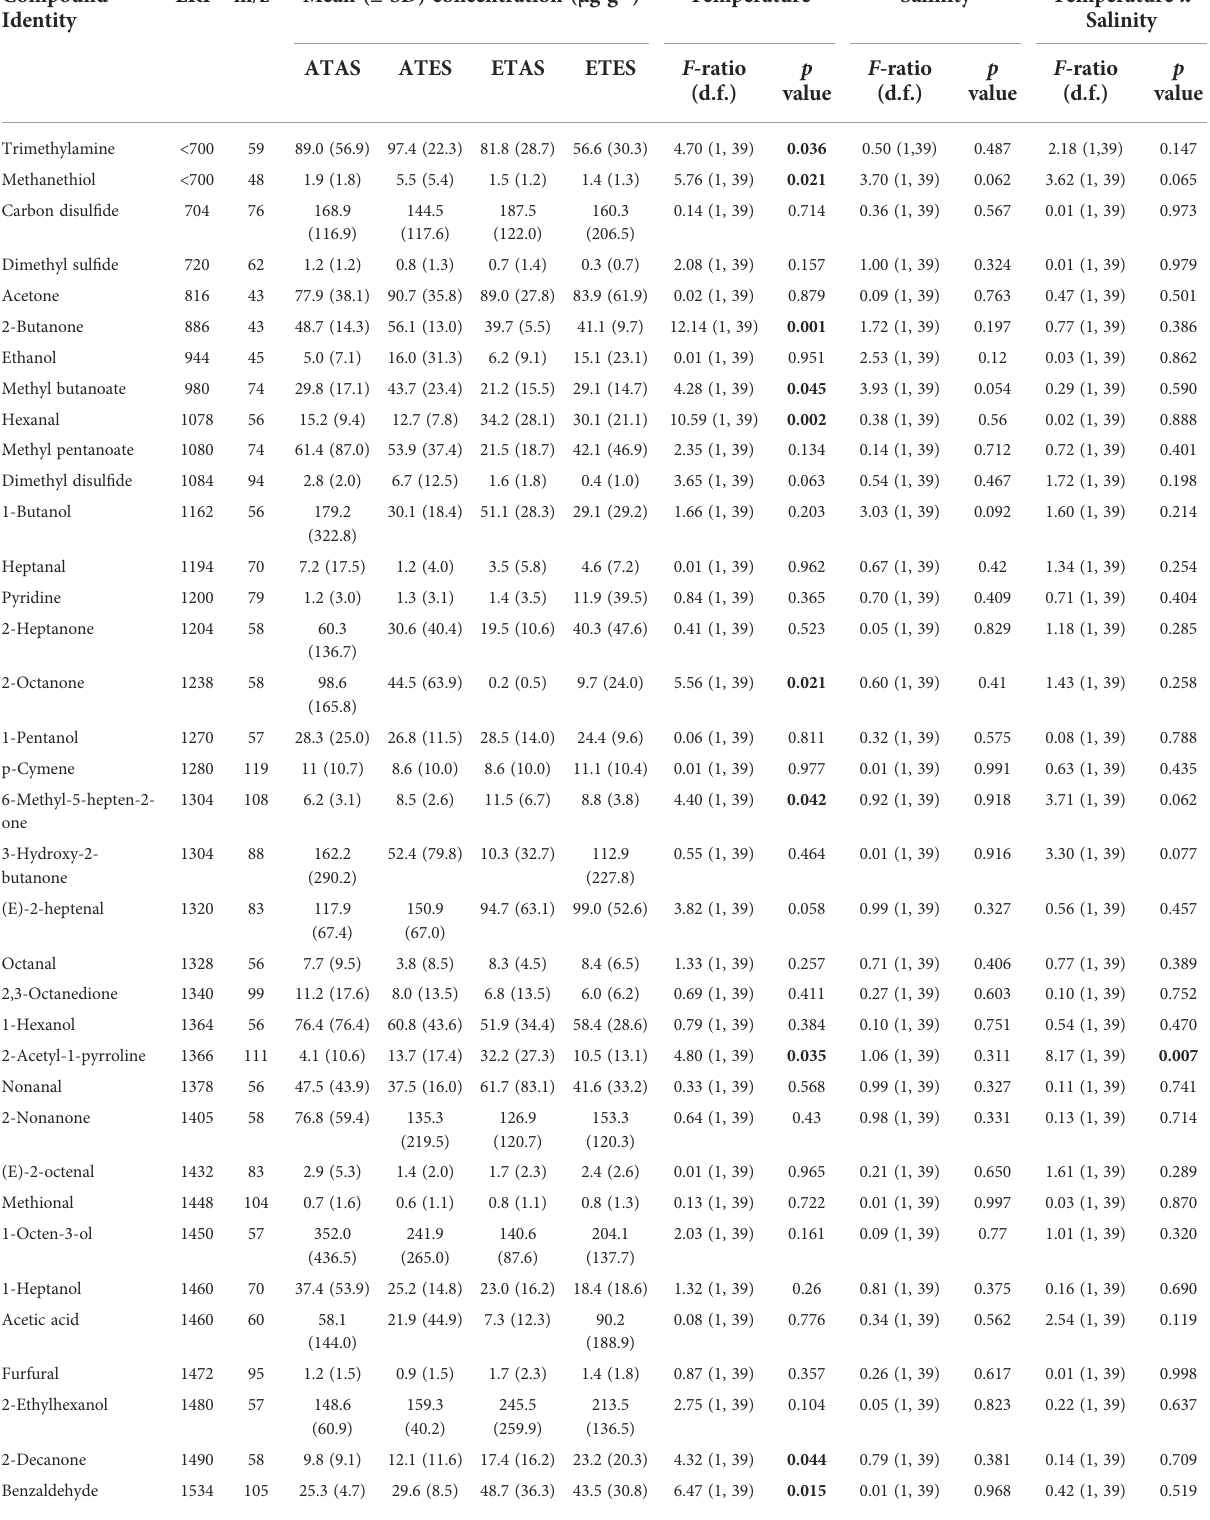
TABLE 1 Summary of volatile compounds ( n = 48) identi fi ed in the meat of blue swimmer crabs ( Portunus armatus ) exposed to elevated temperature and salinity treatments for 30 days.